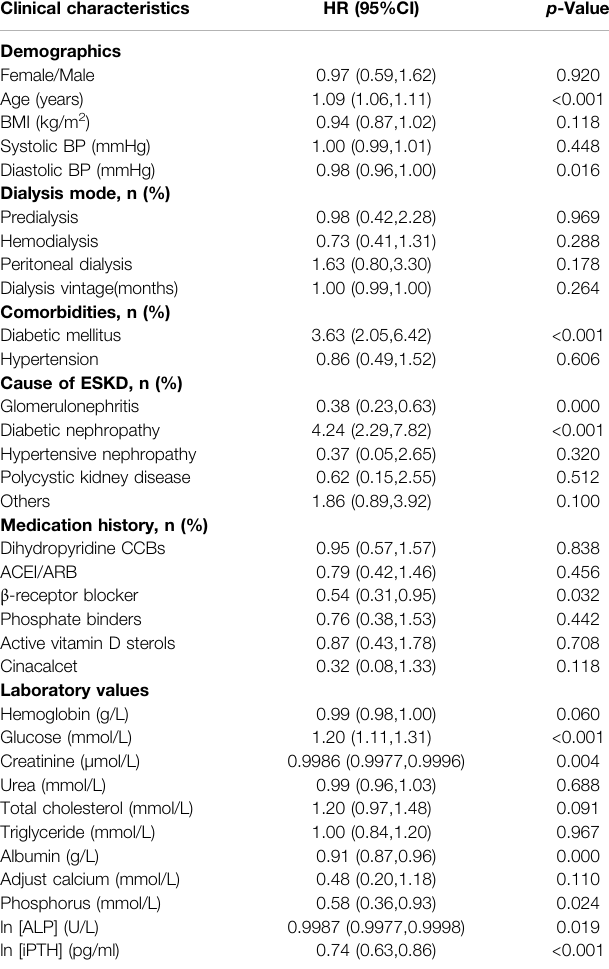
TABLE 3 | Multivariate cox regression of clinical characteristics for all-cause mortality in CKD5 patients. Clinical